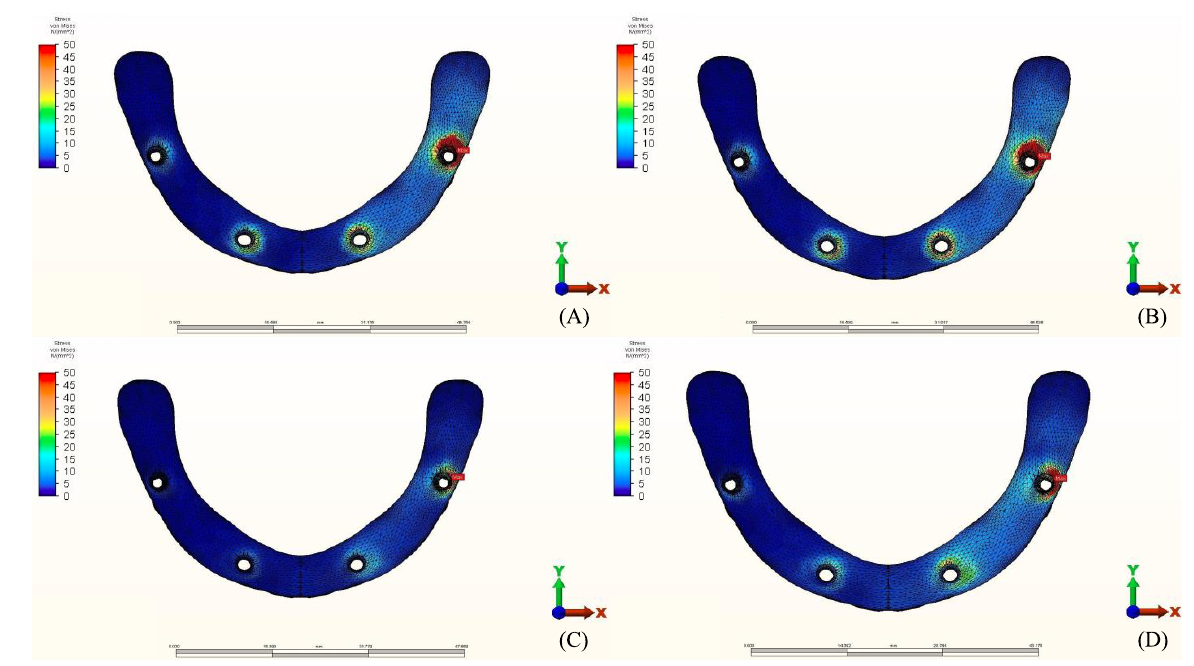
Figure 19. Stress distribution in the framework for group 3, PEEK bar with composite resin gingiva and ceramic superstructure with zirconium (Toronto bridge). ( A ) Model 3.1, opposing natural tooth. ( B ) Model 3.2, opposing tooth-supported full ceramic crown. ( C ) Model 3.3, opposing acrylic prosthesis with titanium framework. ( D ) Model 3.4, opposing implant-supported full ceramic crown.